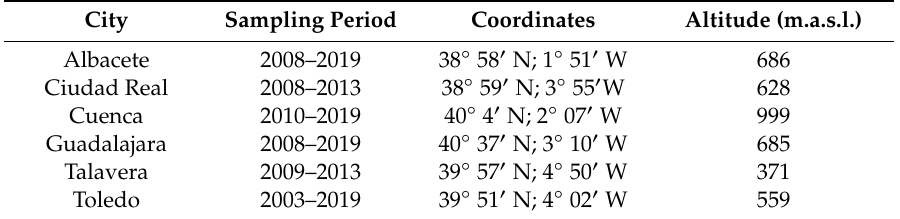
Table 1. Characteristics of aerobiological study stations. m.a.s.l.: meters above sea level.